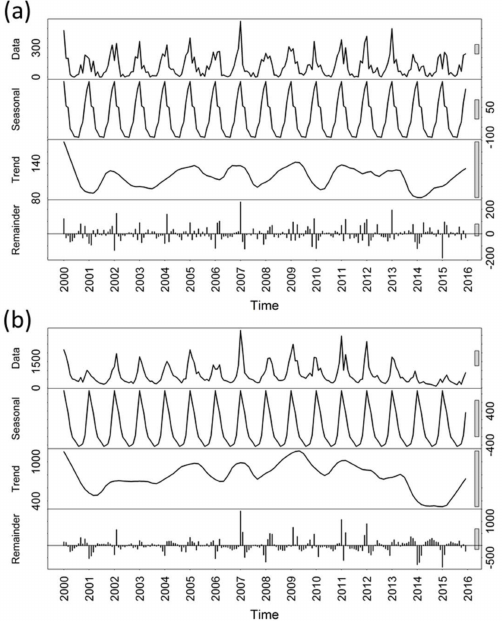
Figure 4. Trend and seasonal decomposition of the historical series (2000–2015): ( a ) precipitation; ( b ) monthly average streamflow observed in the basin outlet (area of direct influence of the Furnas HPP reservoir).